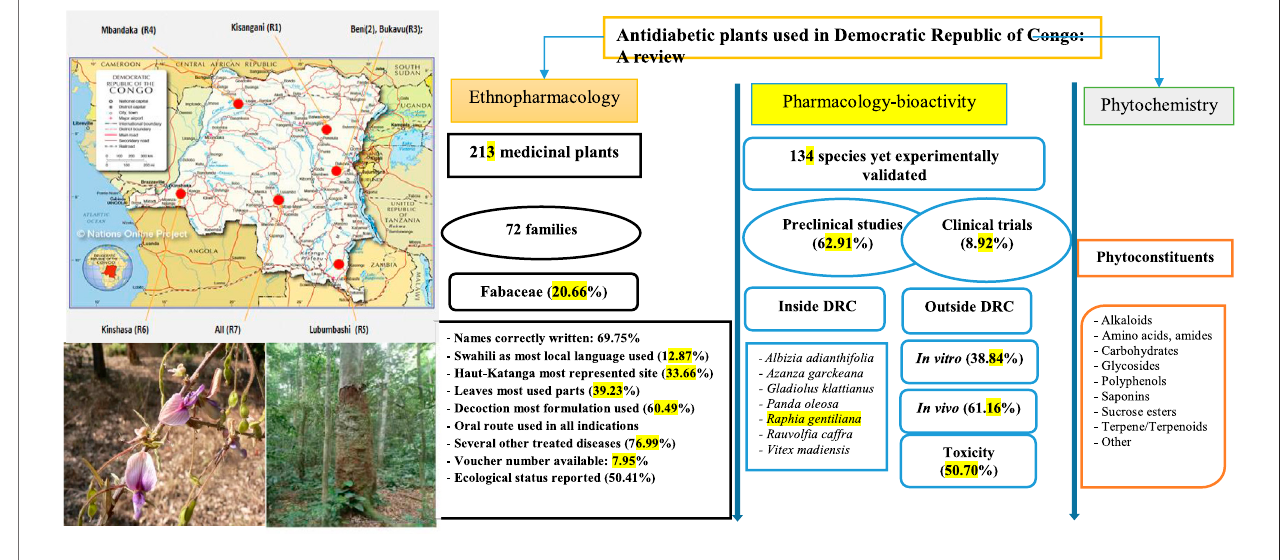
FIGURE 1 | Graphical Abstract.